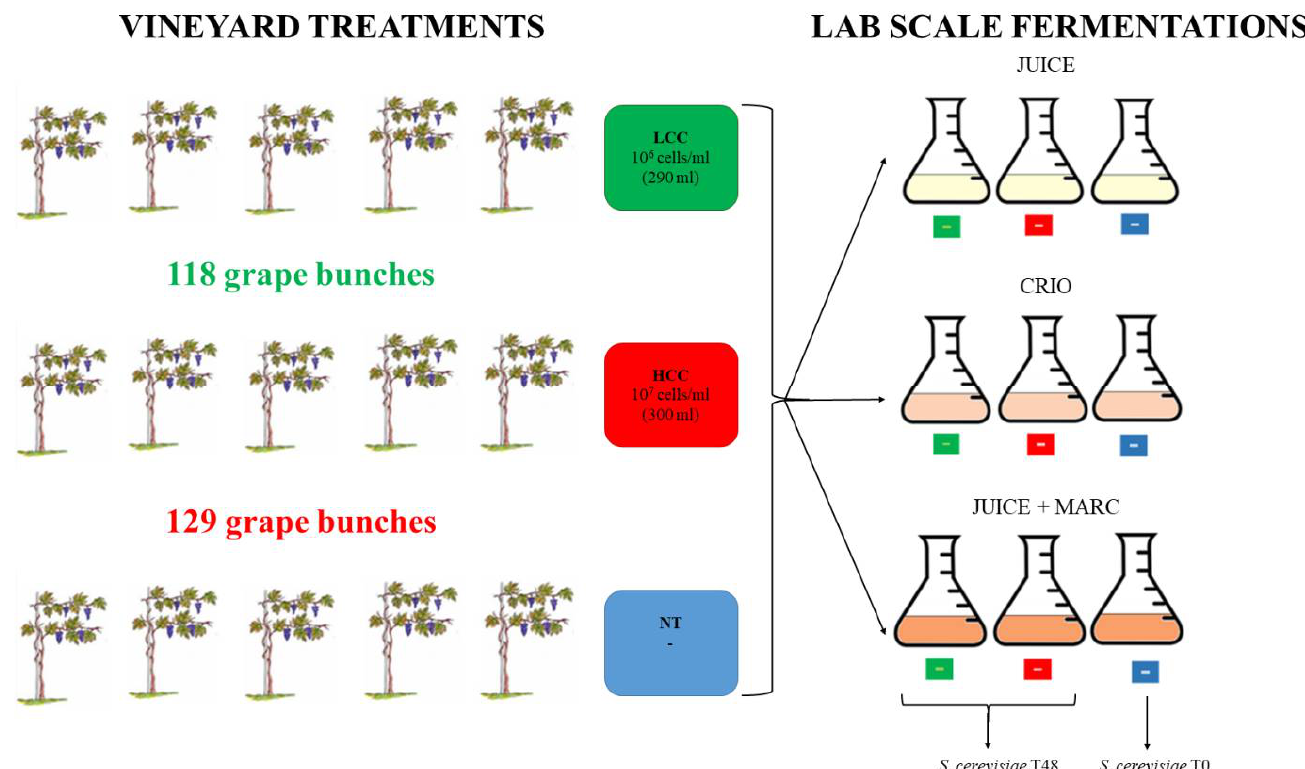
Figure 1. Experimental